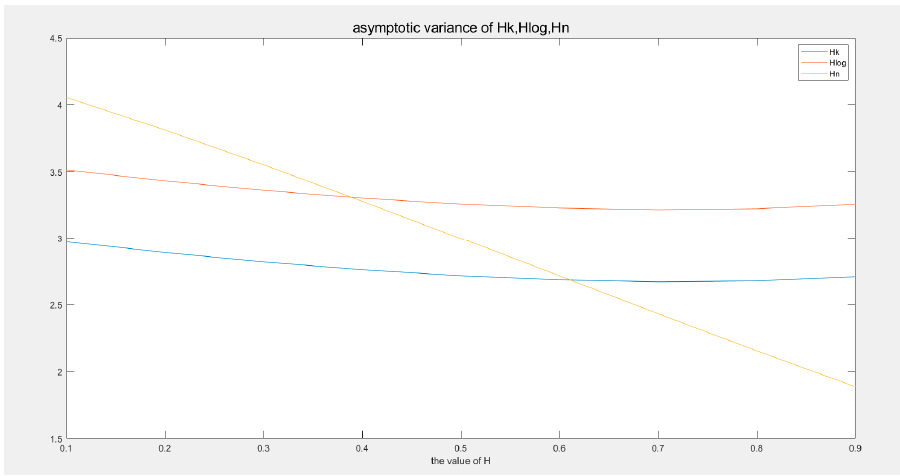
Figure 2. Comparison of asymptotic variance of H n with that of H k and H log